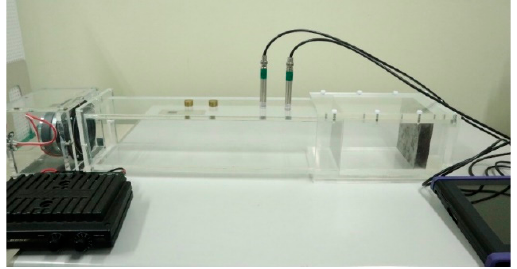
Figure 4. Measurement of the normal incidence absorption coefficient using an impedance tube.